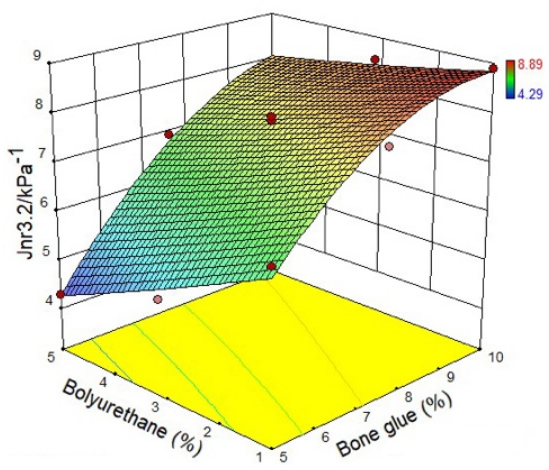
Figure 10. Non-recoverable creep compliance at 3.2 kPa.